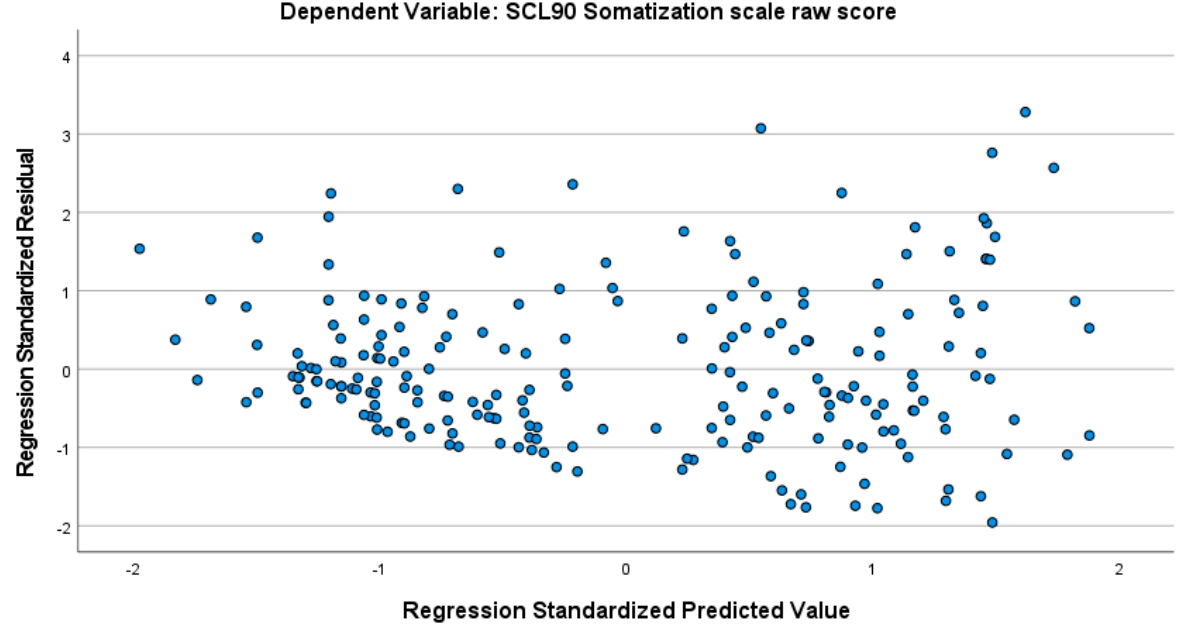
Figure A1. Scatterplot showing standardized residuals for SCL-90 Somatization scale.